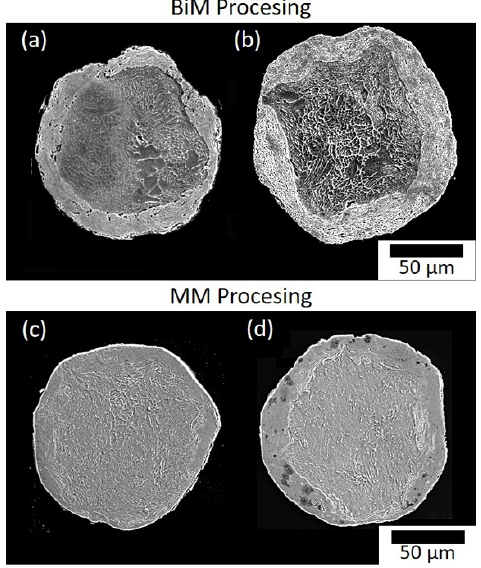
Figure 4. SEM images of SUS316L powders cross-section after BiM and MM processing. ( a ) BiM 36 ks, ( b ) BiM 360 ks, ( c ) MM 108 ks, and ( d ) MM 540